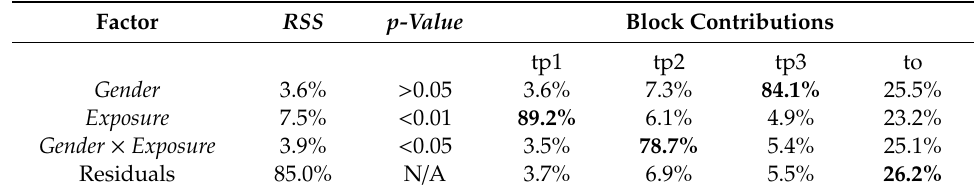
Table 1. Relative variability and block contributions of the AMOPLS analysis of metabolomic data acquired from digestive glands of male and female mussels ( Mytilus galloprovincialis ) exposed to WWTP e ffl uent